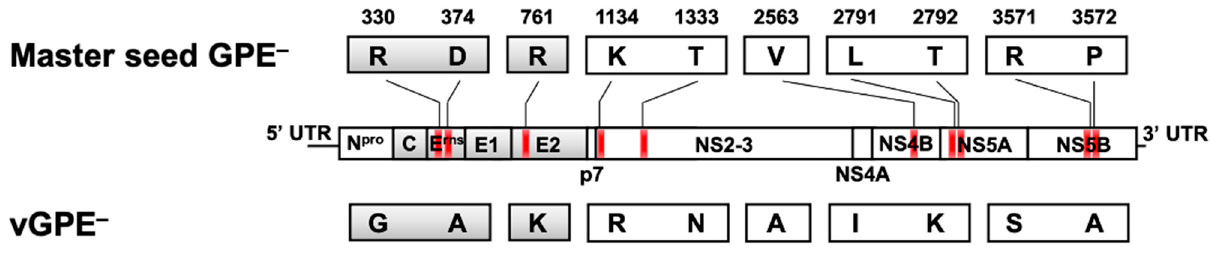
Figure 1. The difference in amino acid sequence between the master seed GPE − and vGPE − . The coding regions of the master seed GPE − (GenBank Accession Number D49533.1) and vGPE − are displayed as boxes divided by each protein gene. Structural proteins and nonstructural proteins are shown in gray and in white, respectively. A total of 10 amino acid substitutions are recognized at positions 330 and 374 in E rns , 761 in E2, 1134 and 1333 in NS2, 2563 in NS4B, 2791 and 2792 in NS5A, and 3571 and 3572 in NS5B. The substitution positions are shown in red on the backbone of vGPE − .